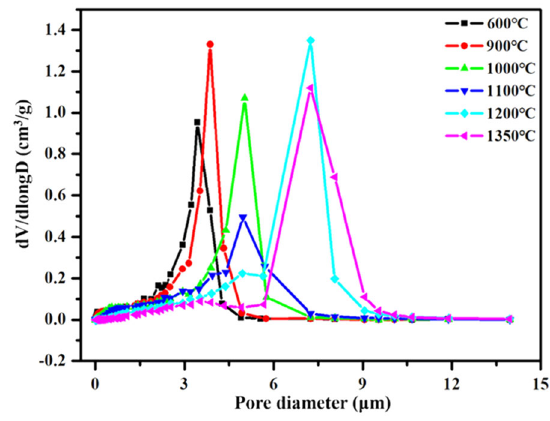
Fig. 5 Pore diameter distribution curves of PCMM at various heat- treatment temperatures. 600 °C (black), 900 °C (red), 1000 °C (green), 1100 °C (blue), 1200 °C (cyan), 1350 °C (magenta).